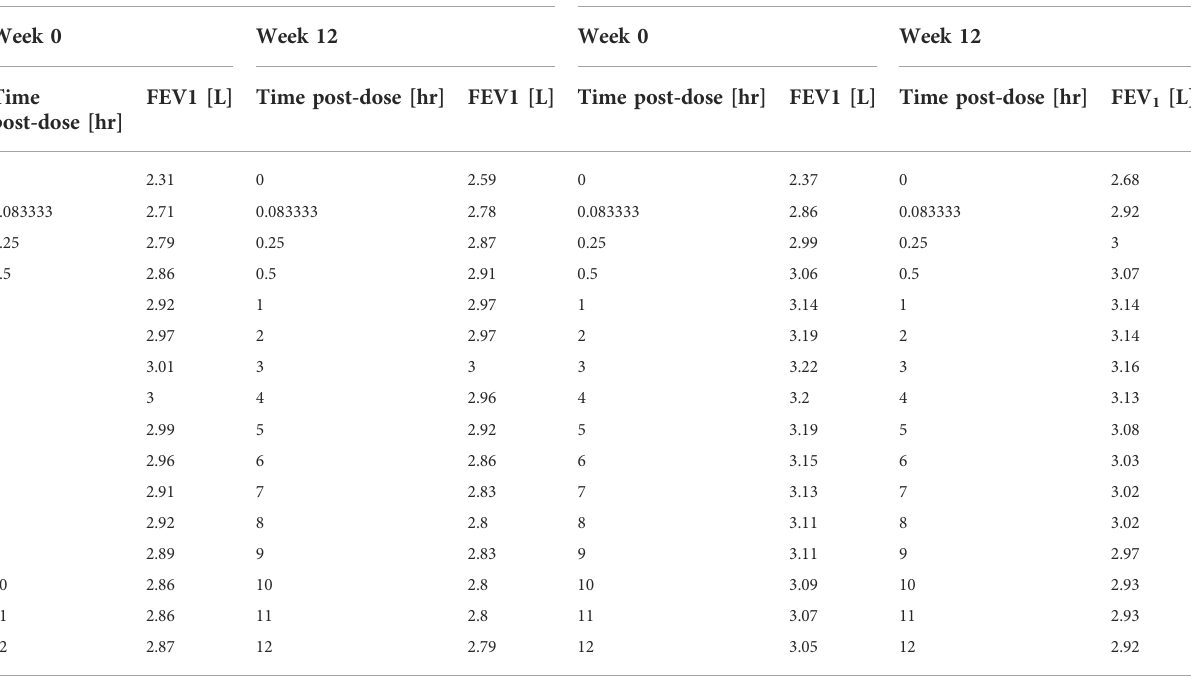
TABLE 2 Pleskow ’ s post-dose observed FEV 1 on the fi rst day (week 0) and at week 12 of double-blind treatment with formoterol 12 μ g or 24 μ g delivered via Aerolizer. Treatment 1: 12 μ g formoterol Treatment 2: 24 μ g